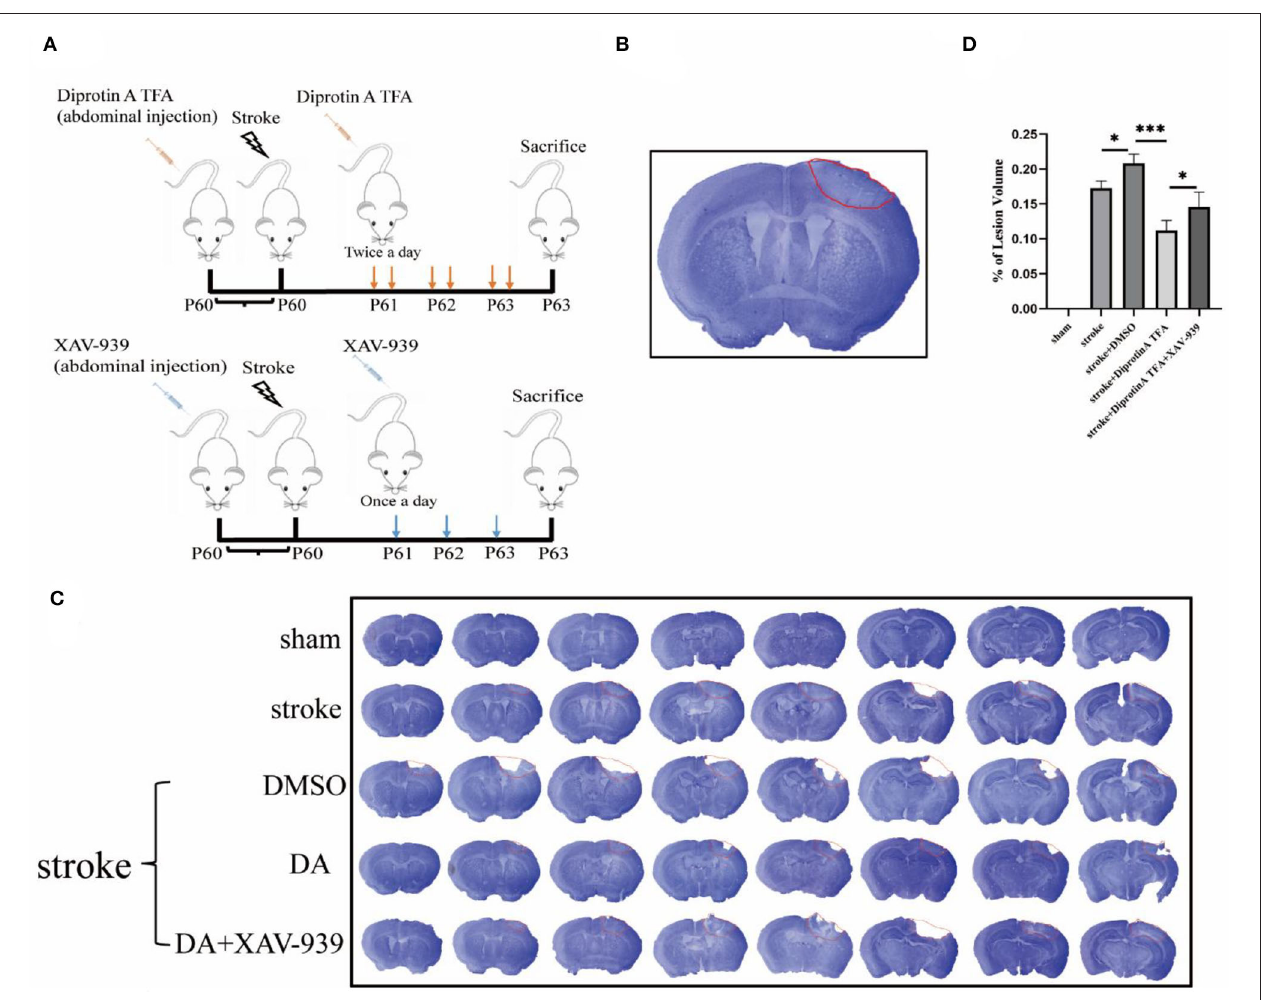
FIGURE 2 | Diprotin A TFA reduces cerebral ischemic damage. (A) A simple diagram of the experimental process time of using mice from intraperitoneal injection of drugs to make a model to perfusing the brain or extracting protein. (B) A Nissl-stained image of a brain slice, with a section thickness of 40 µ m, and the area surrounded by red lines in the upper right part of the brain slice is the infarct area. (C) The Nissl staining of five groups of mice after 3 days of photothrombotic cerebral infarction model, The slice thickness is 40 µ m. (D) Statistical analysis of the cerebral infarction areas of the five groups of mice showed that the cerebral infarction volume of the group injected with DA mice was reduced compared with the vehicle control group. n = 3 per group. Data are represented as mean with SEM. * p < 0.05, *** p < 0.001. DA, Diprotin A TFA; XAV-939, β -catenin